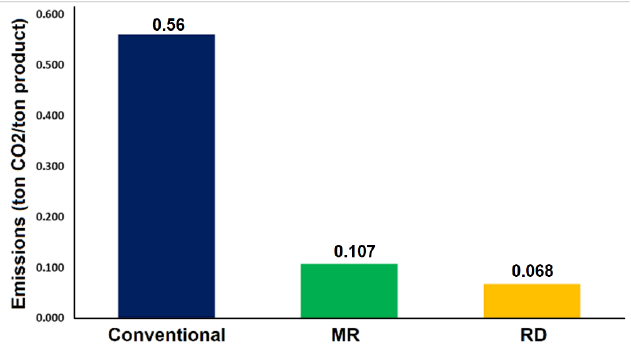
Figure 18. CO 2 emissions per product for the three processes.